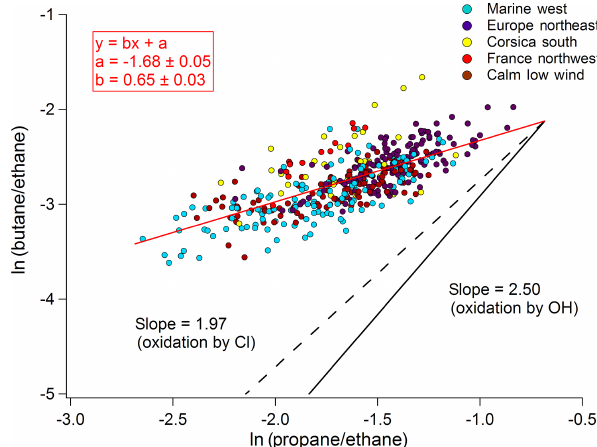
Figure 3. Evolution of ln(butane/ethane) as a function of ln(propane/ethane) during the ChArMEx SOP2 field campaign. The data were color coded as a function of the back-trajectory clus- ters (light blue, purple, yellow, red and brown for the marine west, Europe northeast, Corsica south, France northwest and calm low wind clusters, respectively). The red line corresponds to the linear regression. The black lines correspond to the theoretical kinetic evo- lution of the ratios of alkanes due to oxidation by OH only (solid line) or Cl only (dashed